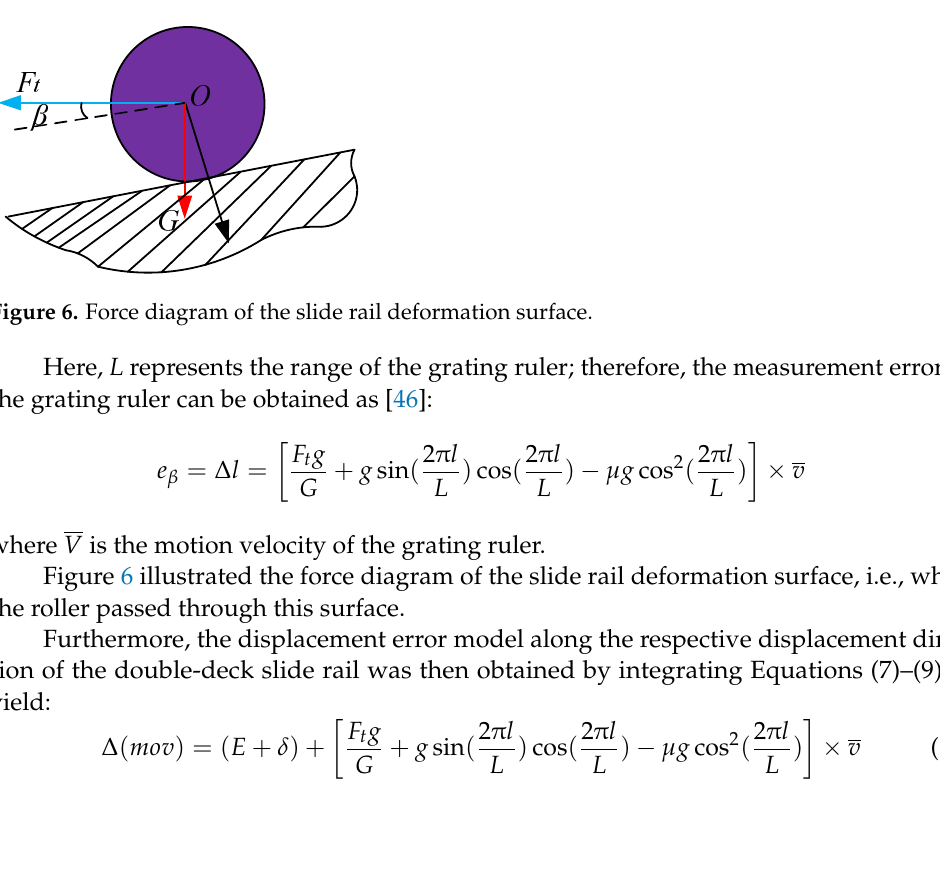
( b ) Figure 7. Illustrating the contact force between the active and passive docking mechanisms ( a ) anal- ysis of forces; ( b ) trajectory of locking jaw. As shown in Figure 7a, during the docking process, there was a certain angular de- viation between the active and passive motion simulators and the origin coordinate sys- tem. The hook claw completed the hugging action and adjusted the attitude deviation under the action of the three V-shaped guide grooves, and finally reached the bottom of the V-groove to complete the docking operation. In this analysis, the collision types were